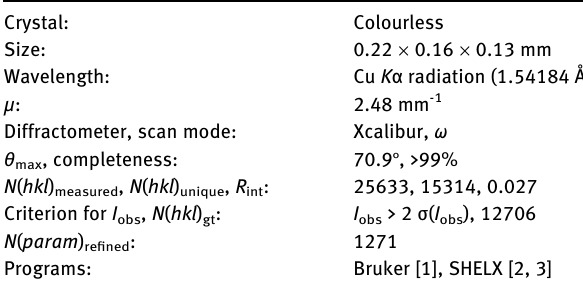
Table  : Fractional atomic coordinates and isotropic or equivalent isotropic displacement parameters (Å 